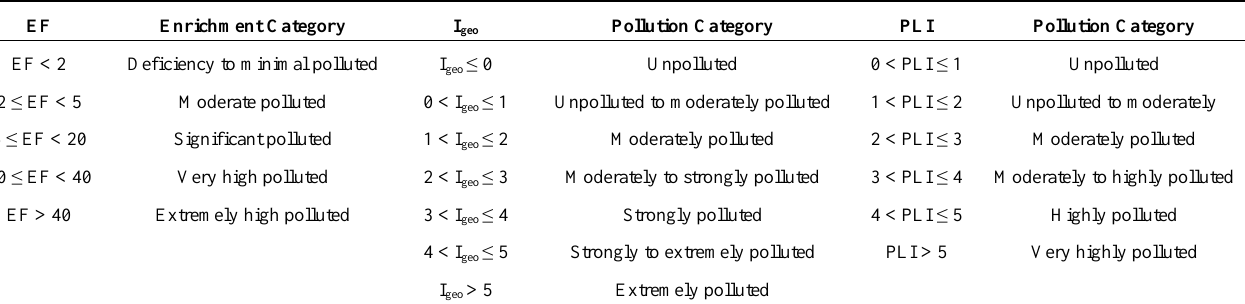
Table 1. Pollution index and pollution